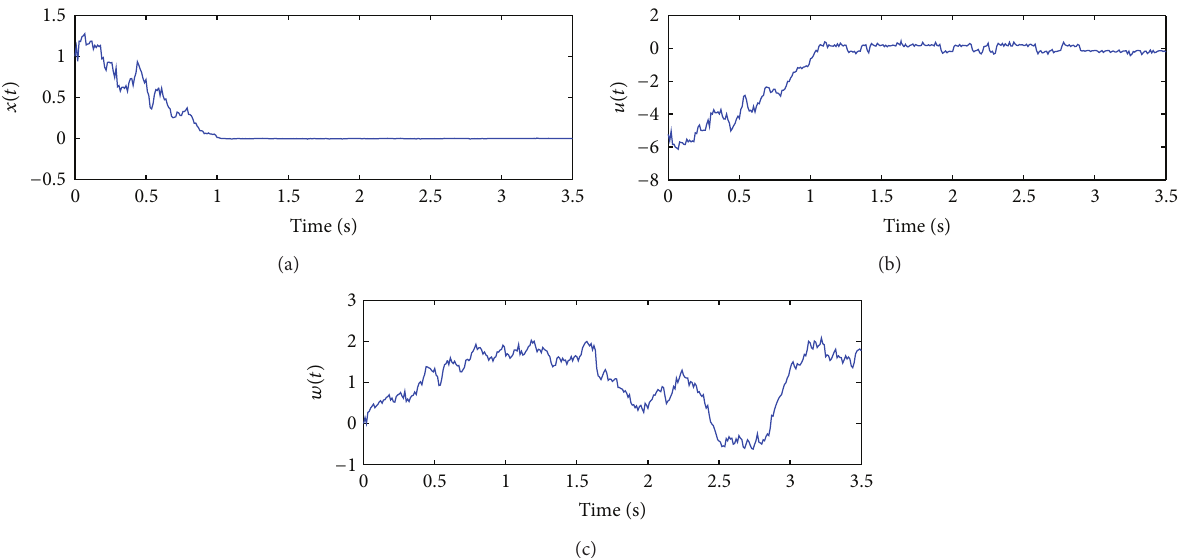
Figure 1: The response of the state 𝑥(𝑡) , the control 𝑢(𝑡) , and the Wiener process 𝑤(𝑡) in Example 1 for initial conditions as 𝑥(0) = 1.